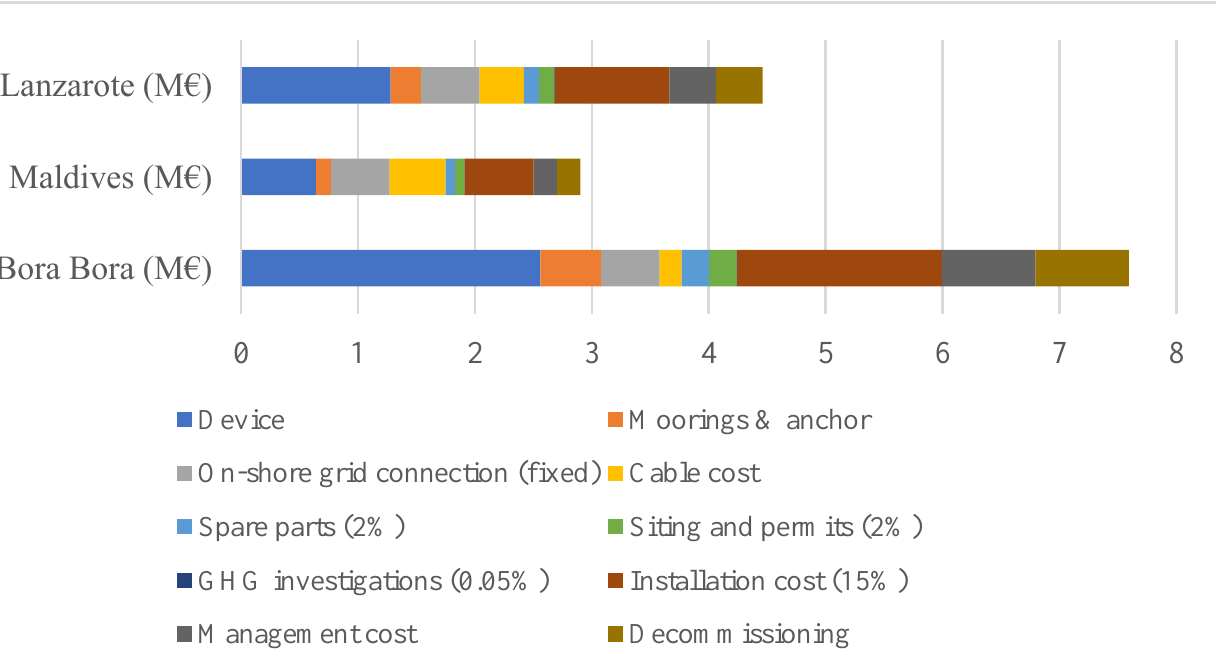
Figure 8. Cost center breakdown of the CAPEX in the three locations (Adapted with permission from Ref. [98]. 2016, Sandberg, A.B., et al.).